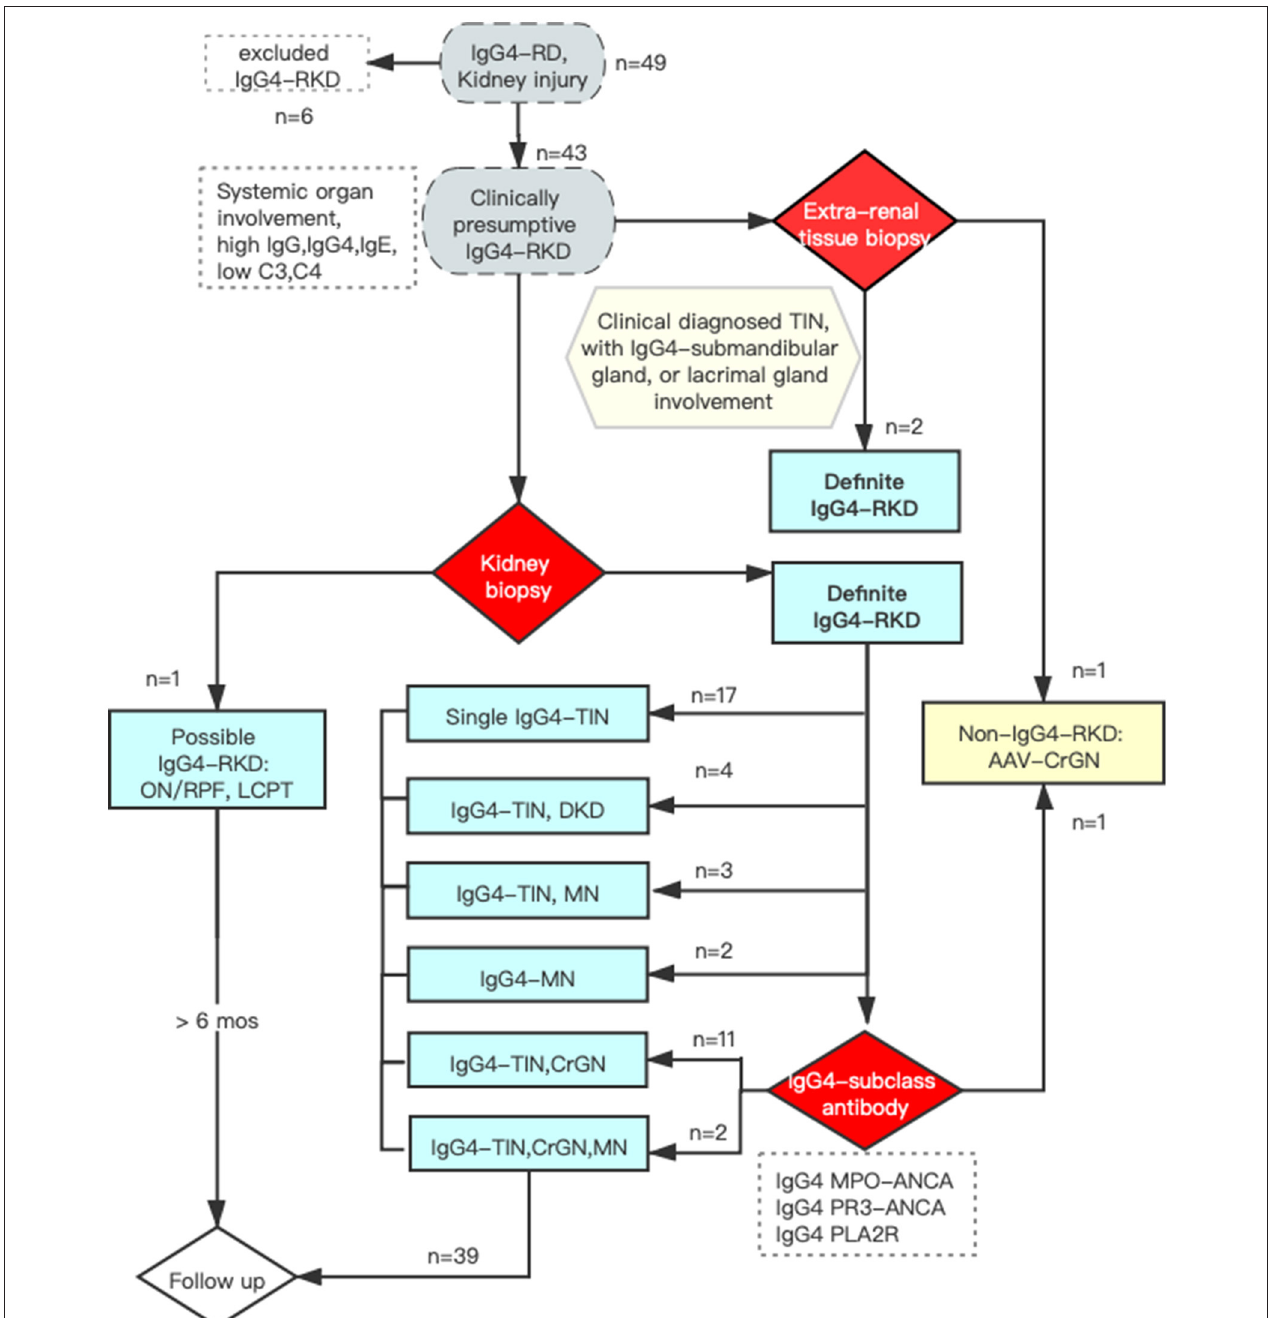
FIGURE 1 | The flow chart of the